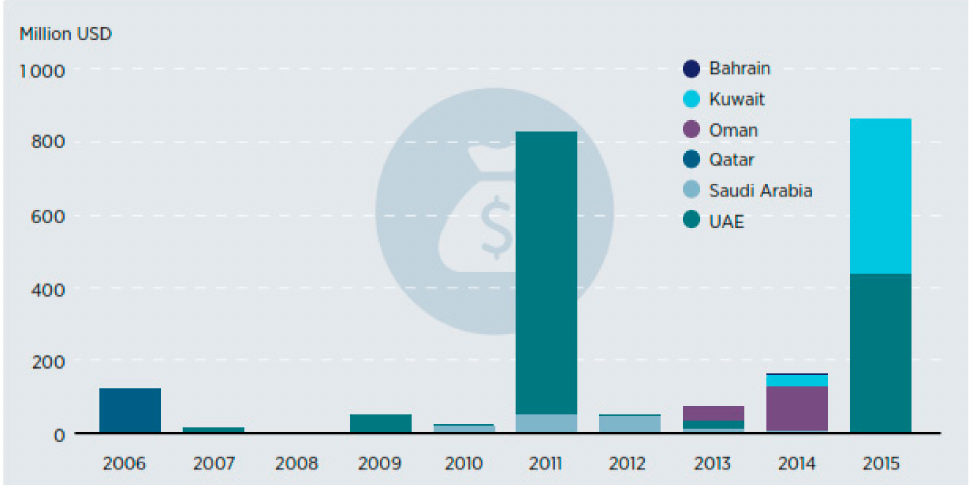
Figure 1. Investment in GCC Renewable Energy from 2006 to 2015 [8].